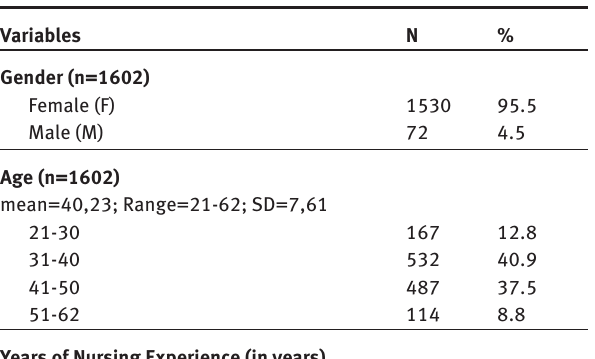
Table 1: Socio-demographic characteristics of